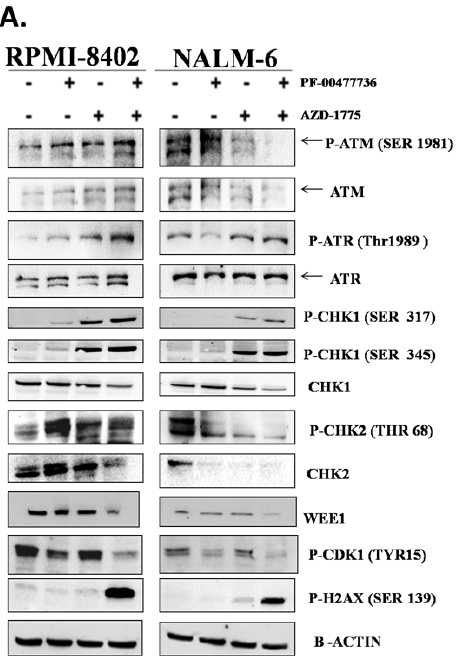
Figure 3. The combination triggers the DDR pathway and induces DNA damages independently for p53 functionality. ( A ) Western Blot analyses of RPMI-8402 and NALM-6 cell lines treated for 24 h with AZD-1775 (185 nM) and PF-00477736 (25 and 250 nM respectively). β -actin was used for loading normalization. For relative quantification of each protein see Figure S2 and for whole western blot images see Figure S5. ( B ) Western Blot analyses of RPMI-8402 and NALM-6 cell lines treated for 24 h with AZD-1775 (185 nM) and PF-00477736 (25 and 250 nM respectively). β -actin was used for loading normalization. For relative quantification of each protein see Figure S3A and for whole western blot images see Figure S6.